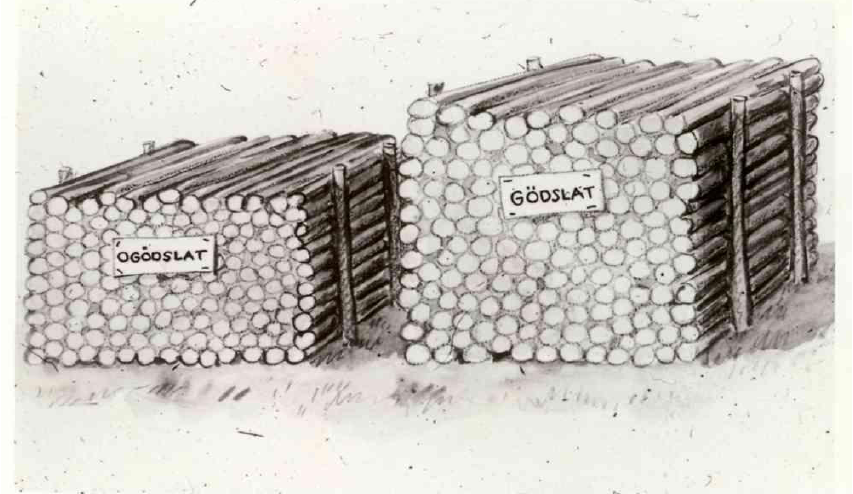
Figure 2. Illustration showing the difference between a timber harvest from a non-fertilized forest (to the left) and a fertilized forest (to the right). Source: Supra AB‘s Archive, Skånes Näringslivsarkiv, Helsingborg, Sweden. Painter